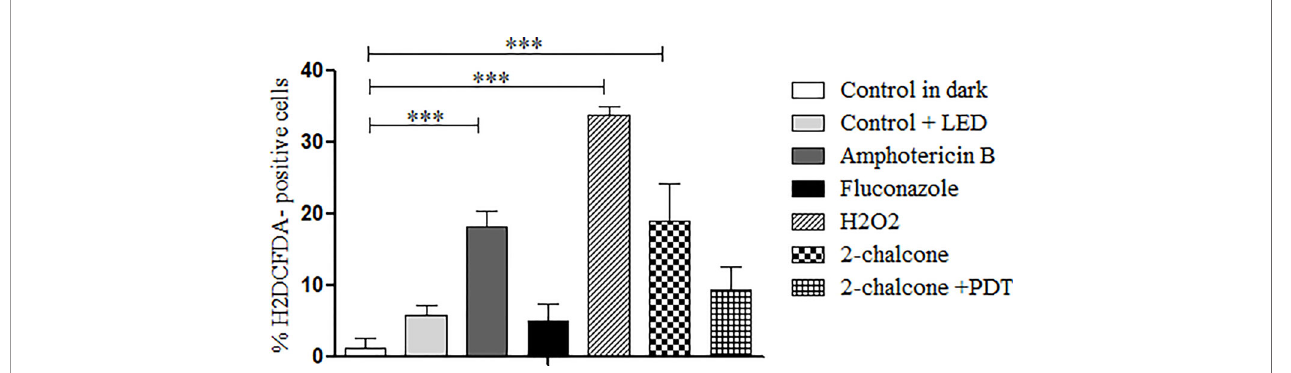
FIGURE 9 | Measurement of ROS production after treatment of T. rubrum ATCC 28189 with 2-chalcone in the dark and mediated PDT (2-chalcone + LED). The compounds amphotericin B, hydrogen peroxide, and 2-chalcone in the dark induced ROS formation when compared to the control without treatment in the dark. Treatment with 2-chalcone-mediated PDT did not induce ROS formation when compared to the control + LED. ***p <0.001.